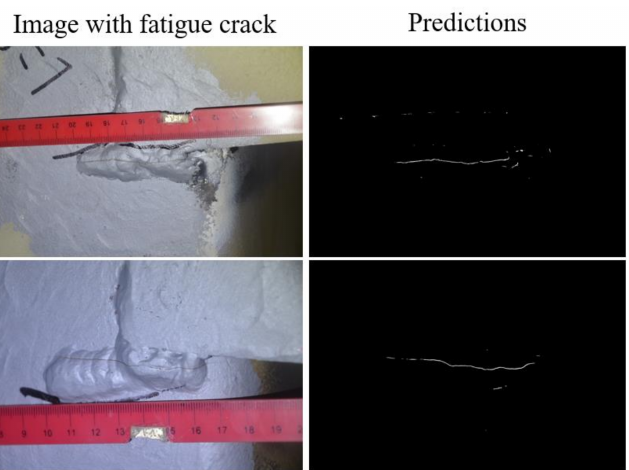
Figure 7. Fatigue crack predictions on the images with unknown objects in the training and test- ing